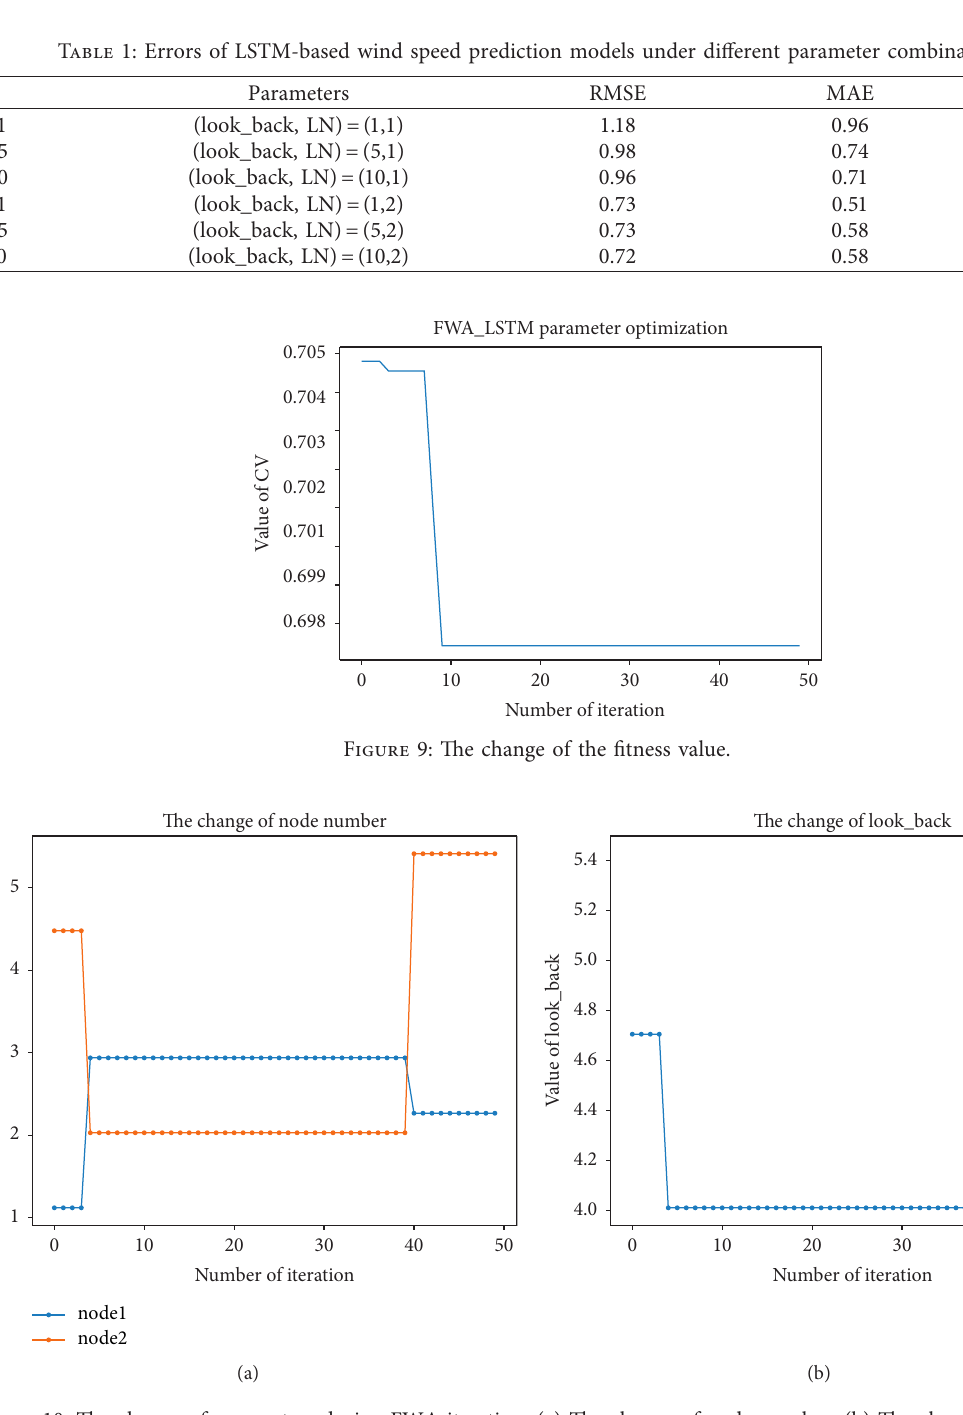
Figure 10: The change of parameters during FWA iteration. (a) The change of node number. (b) The change of time